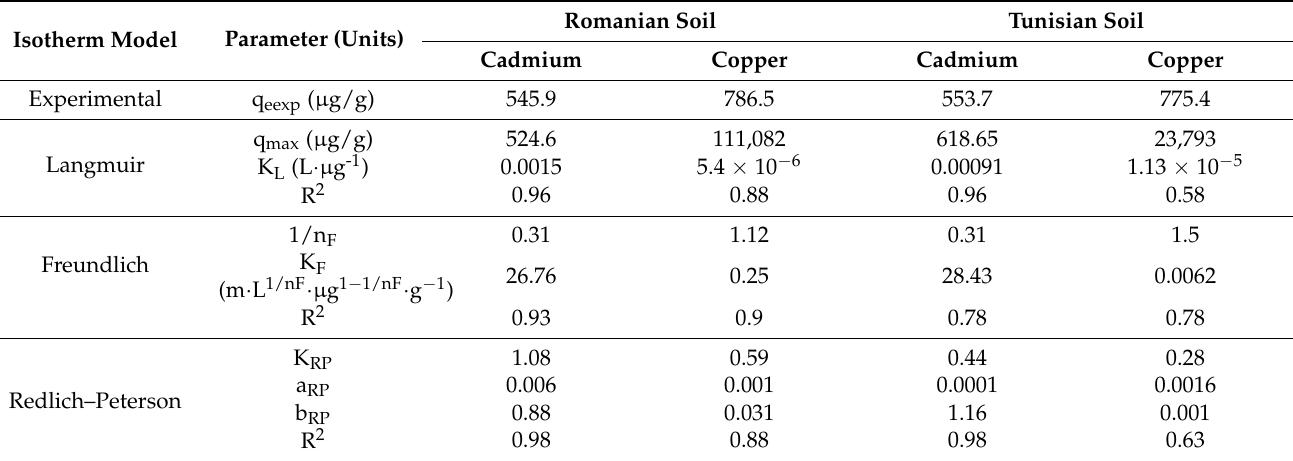
Figure 3. Cadmium and copper adsorption kinetics in Romanian and Tunisian soils (T = 22 °C, 260 rpm, m/V = 0.1 g·mL −1 , pH = 7.0 – 7.5). Table 3. Fitting of the unary isotherm parameters of cadmium and copper adsorption in Tunisian and Romanian